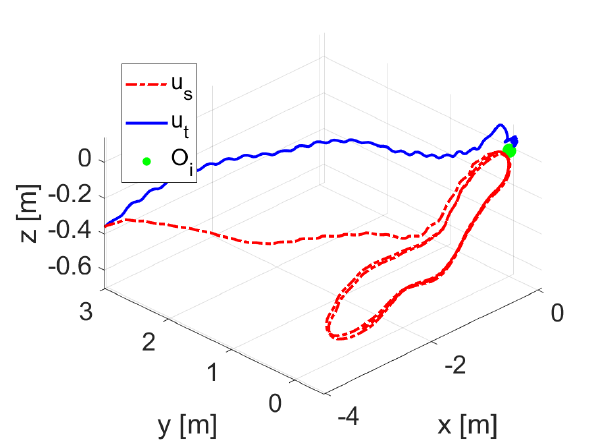
Figure 12. Trajectories obtained by u s and u t for the AUV of F t , he maximal thrusts of the four horizontal thrusters were modified to 50 N , 80 N , 10 N , and 50 N .